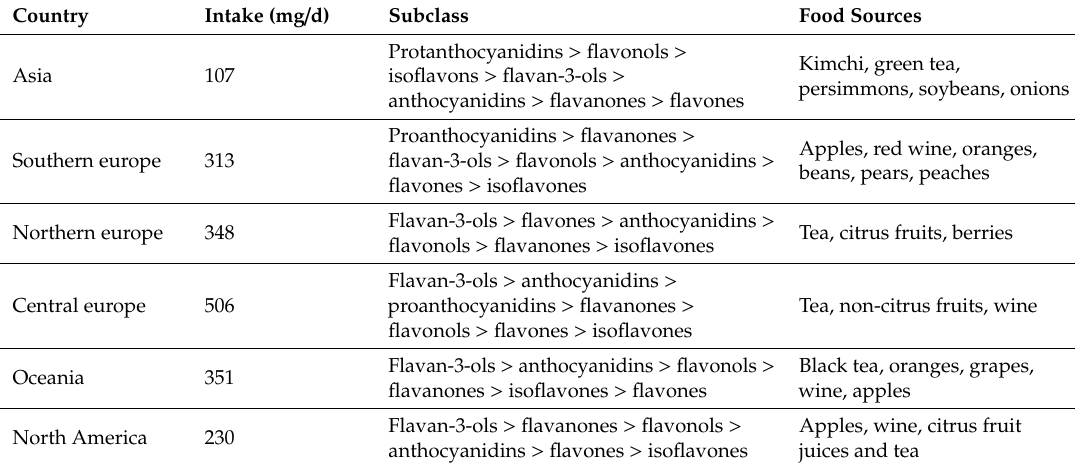
Table 9. Flavonoids intake and main food sources